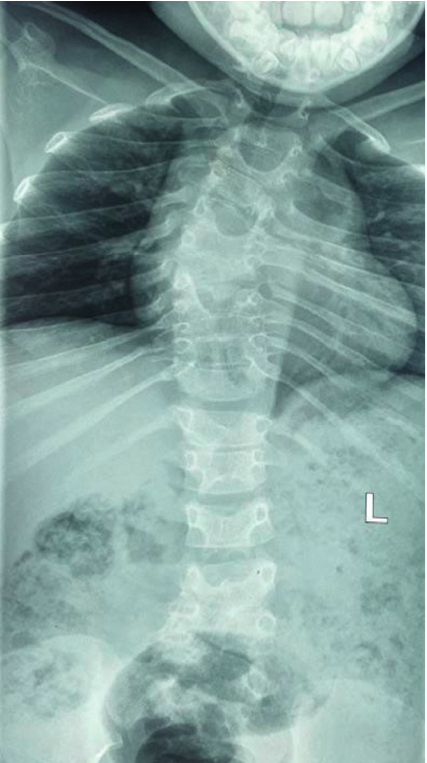
Figure 2: X-ray of thoracolumbar spine showing multiple fused, butterfly vertebrae and asymmetrical rib